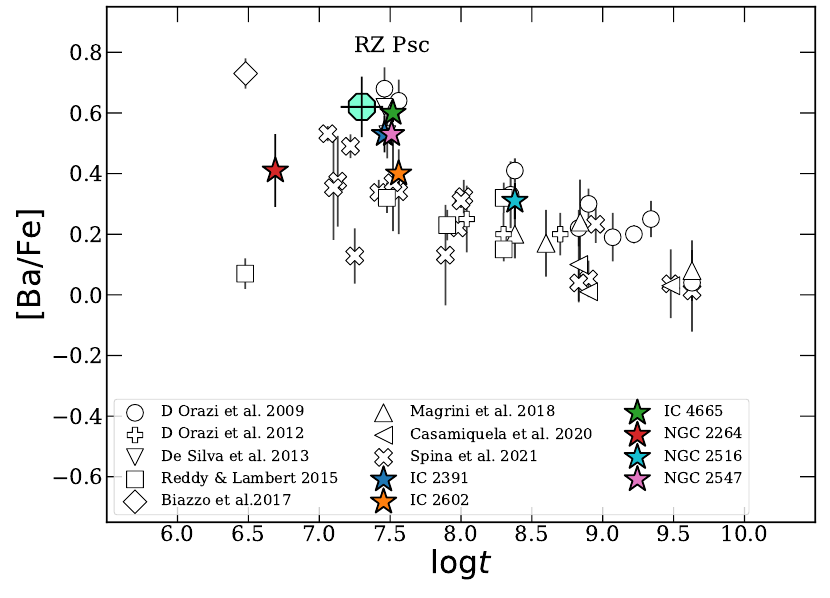
Figure 4. [Ba/Fe] ratios as a function of age (time in years) for clusters analysed in Baratella et al., 2021, along with previous results. The new determination of RZ Psc is labelled as a cyan octagonal symbol. For RZ Psc we adopted an age of 20 ± 5 Myr, which includes the different range reported in the literature (see discussion in the main text). The ages reported for OCs come from a single source, as detailed in Baratella et al. 2021 [39]. Credit: Figure adapted from Baratella et al. A&A, 653, A67, 2021, and reproduced with permission ©